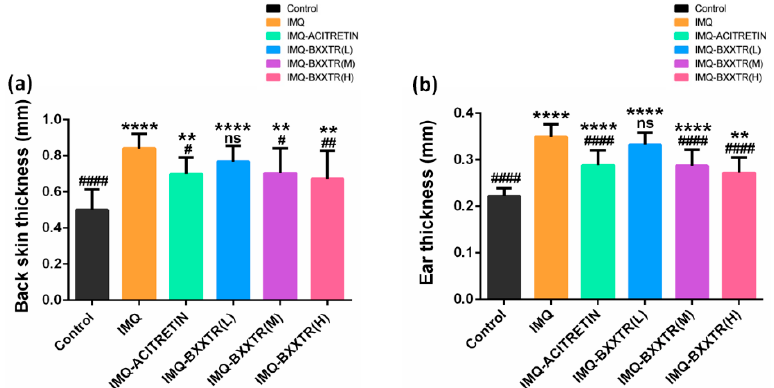
Figure 2. Survey thickness of back skin and right ear. The severity of psoriatic-like lesion induced by IMQ cream treatment was evaluated by measuring the thickness of the back skin and right ear. ( a ) Skin thickness on the backs of BALB/c mice; ( b ) right ear thickness of BALB/c mice. Bar diagram is expressed as group means ± SD of the skin or ear measurements on day 56 ( n = 10 for each group). Column with * or # above manifests a significant difference between groups ( p < 0.05) and “ns” means no significant difference. ** p < 0.01, **** p < 0.0001, vs. control; # p < 0.05, ## p < 0.01, #### p < 0.0001, vs. IMQ;